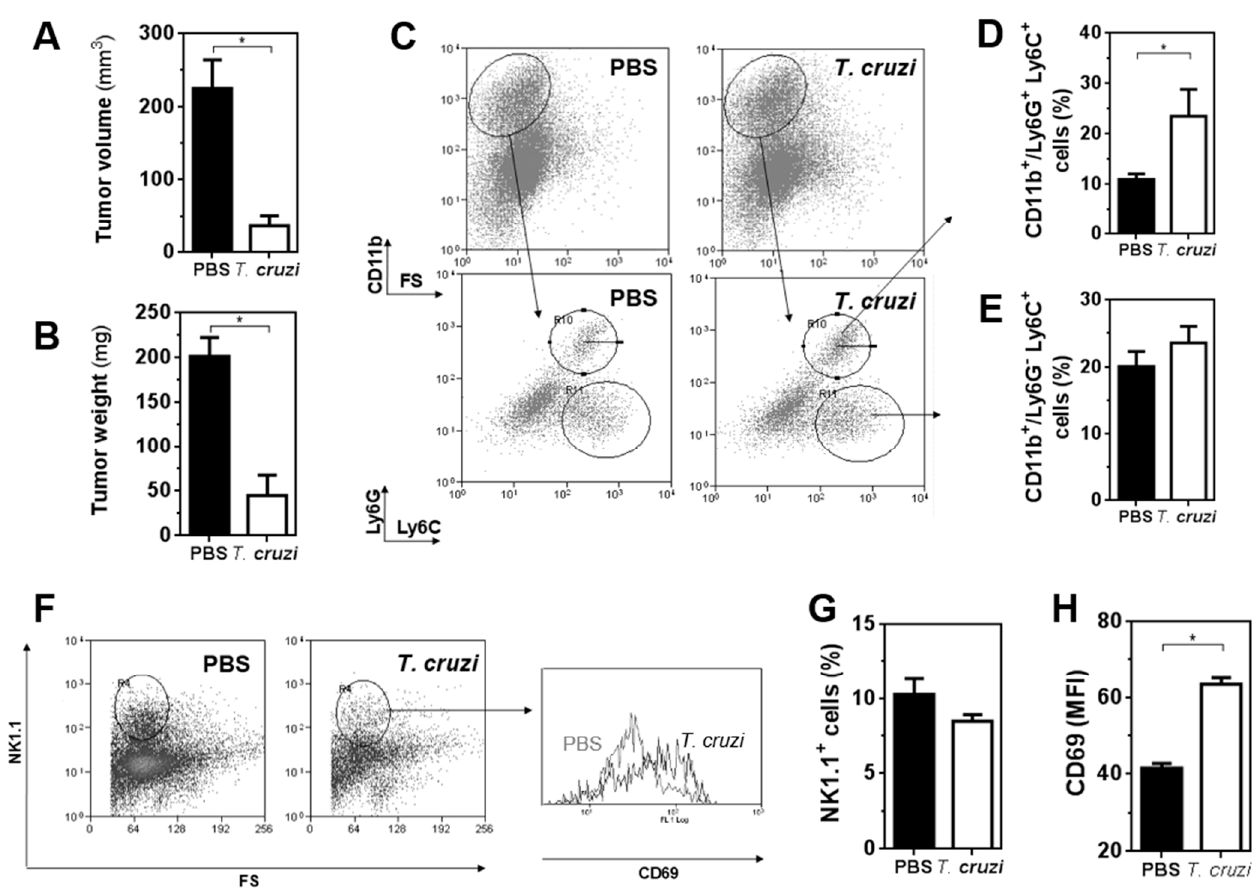
Figure 2. Analysis of the innate-associated cells in the tumour microenvironment of mice pre-treated with T. cruzi lysate and challenged with LL/2 tumour cells: ( A ) C57BL/6 mice were pre-treated three times in two-week intervals with T. cruzi or PBS in alum before LL/2 cells challenge (100,000 cells/mouse). On day 19, animals were sacrificed and tumours were removed. Tumours were either measured with a calliper ( A ) or weighed ( B ). Alternatively, tumours were stained either with anti- CD11b, Ly6G and Ly6C antibodies ( C – E ) or with anti-NK1.1 and -CD69 antibodies ( F – H ) and analysed by flow cytometry. ( C ) Gating strategy for CD11b + cells. Frequencies of CD11b + /Ly6G + Ly6C + ( D ) and CD11b + /Ly6G − Ly6C + ( E ) cells. ( F ) Gating strategy for NK1.1 + cells. ( G ) Frequencies of NK1.1 + cells. ( H ) Expression of CD69 on NK1.1 + cells. Representative results from three independent exper- iments are shown (±SEM, indicated by error bars). Asterisks indicate statistically significant differ- ences (* p < 0.05) Representative results from two independent experiments are shown.